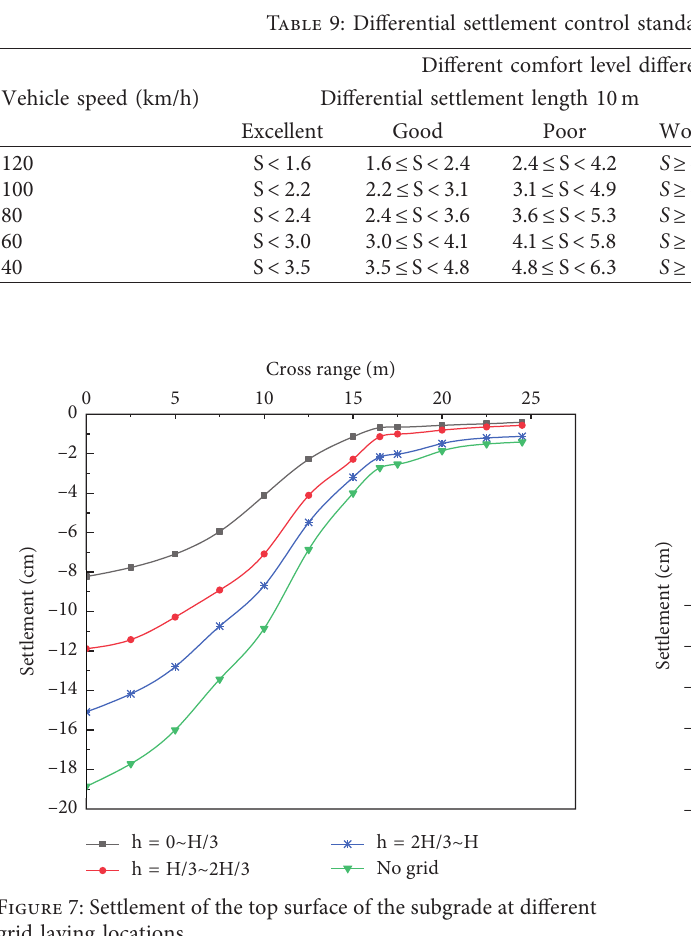
Figure 8: Settlement of the top surface of the subgrade at different grid laying